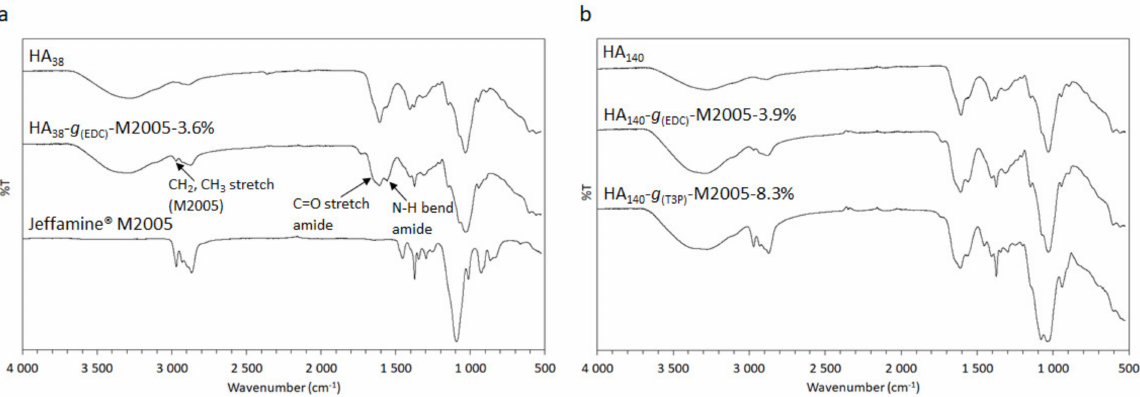
Figure 1. ( a ) FTIR spectrum of HA 38 ( top ), HA 38 -g (EDC) -M2005-3.6% ( middle ), and M2005 ( bottom ) and ( b ) HA 140 ( top ), HA 140 -g (EDC) -M2005-3.9% ( middle ), and HA 140 -g (T3P) -M2005-8.3% ( bottom